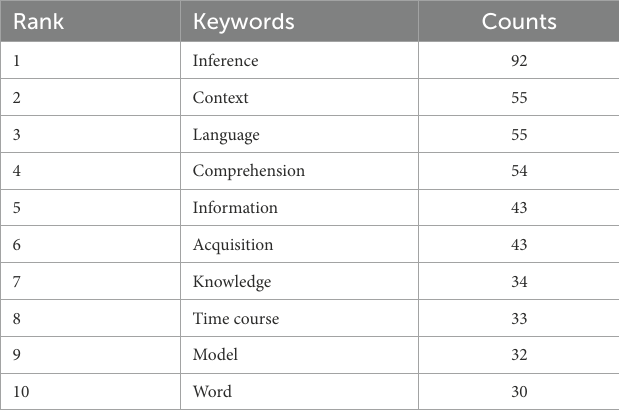
TABLE 3 The top ten most frequent co-occurring keywords in lexical inferencing.